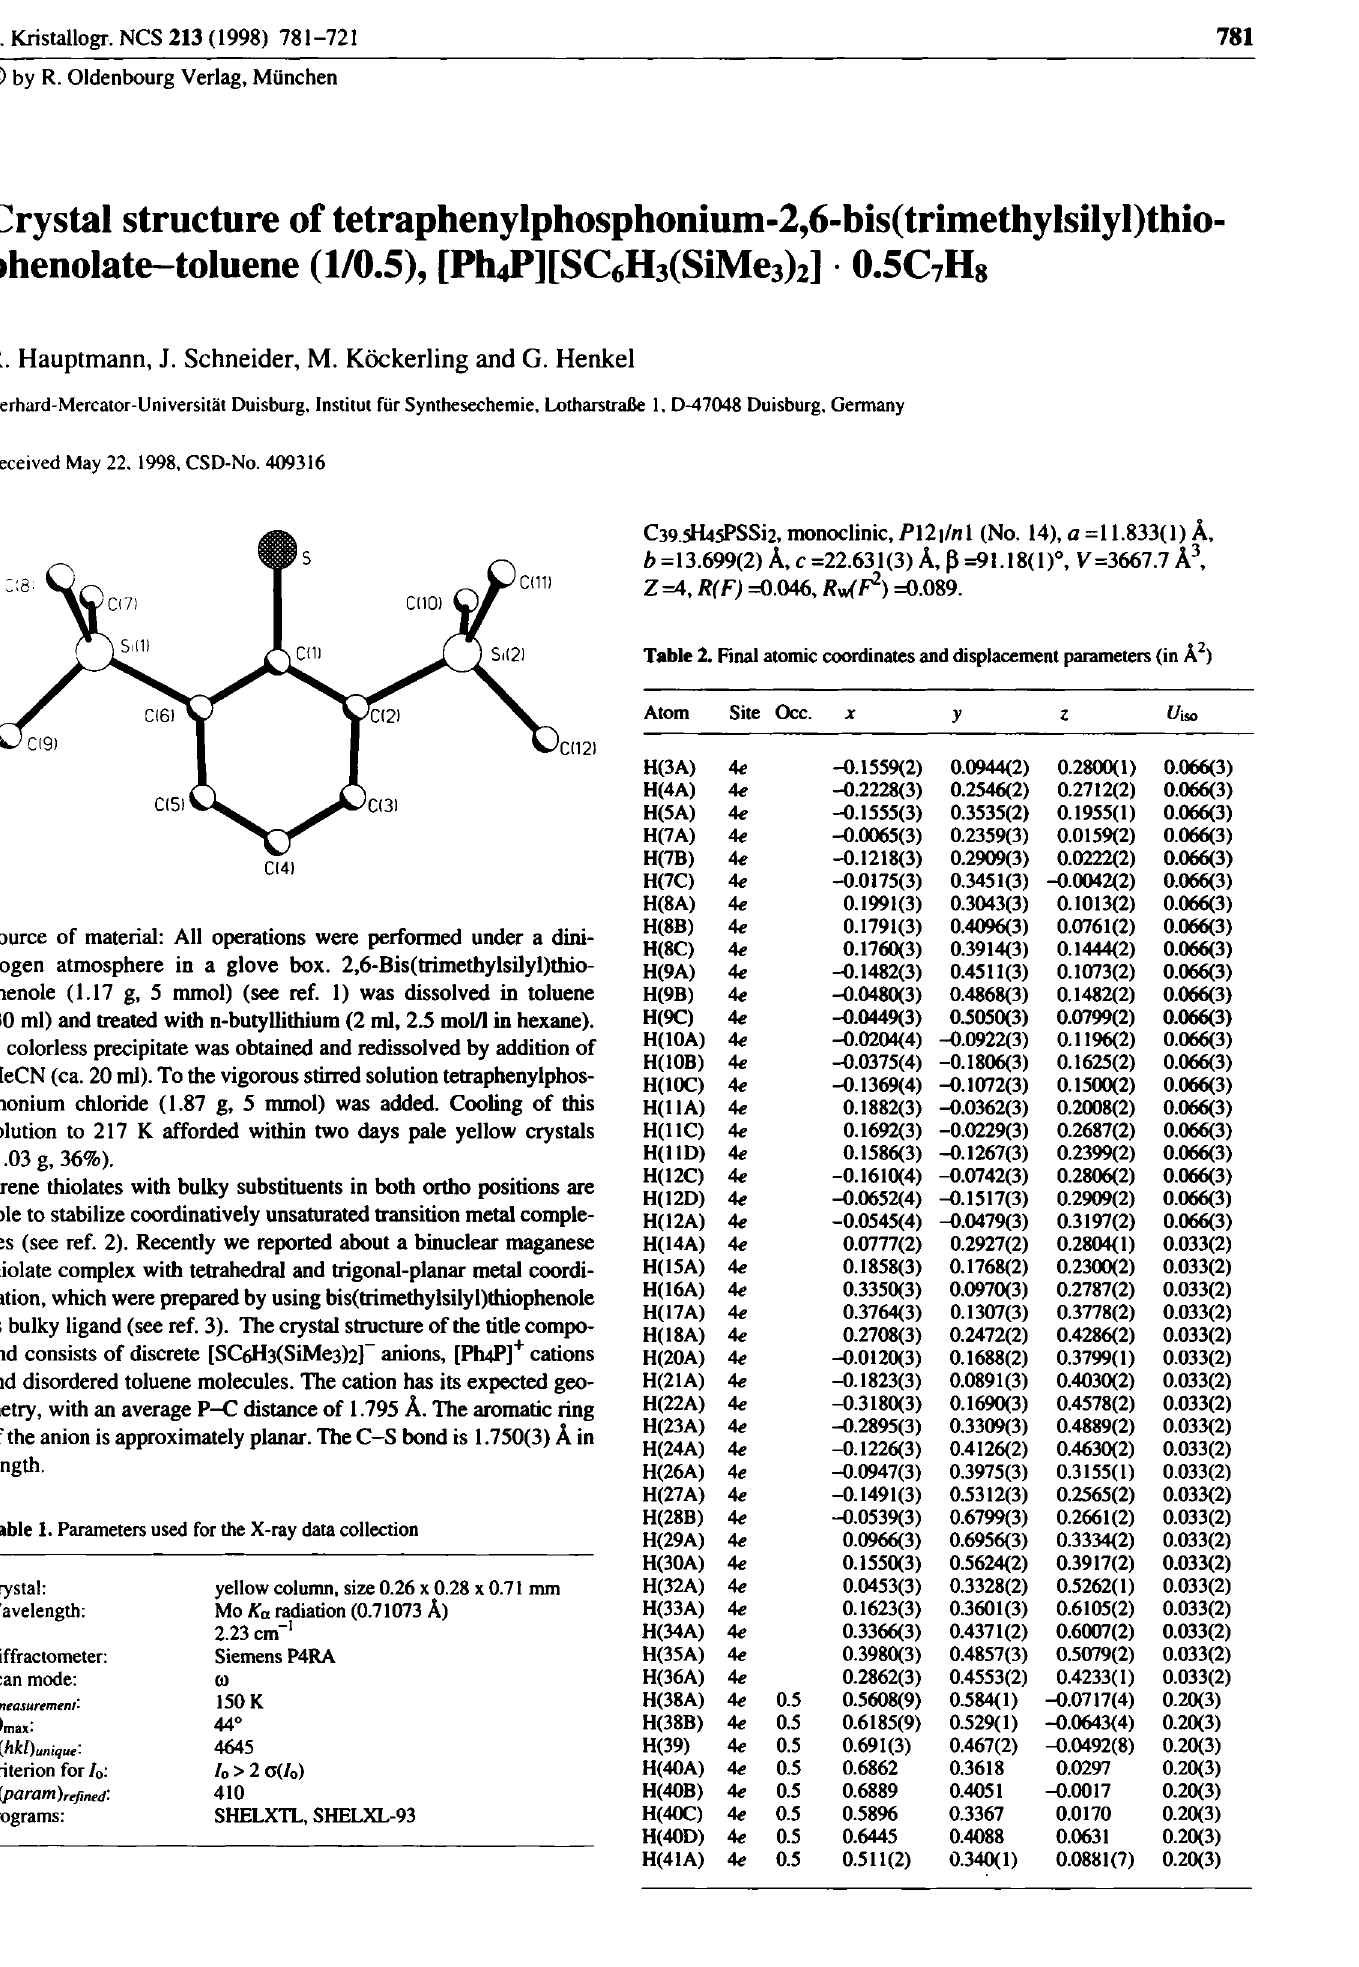
Table 1. Parameters used for the X-ray data collection Crystal: